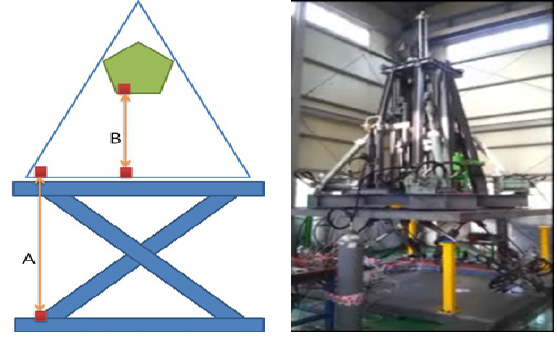
Figure 2. Schematic of displacement measurement in the test rig.